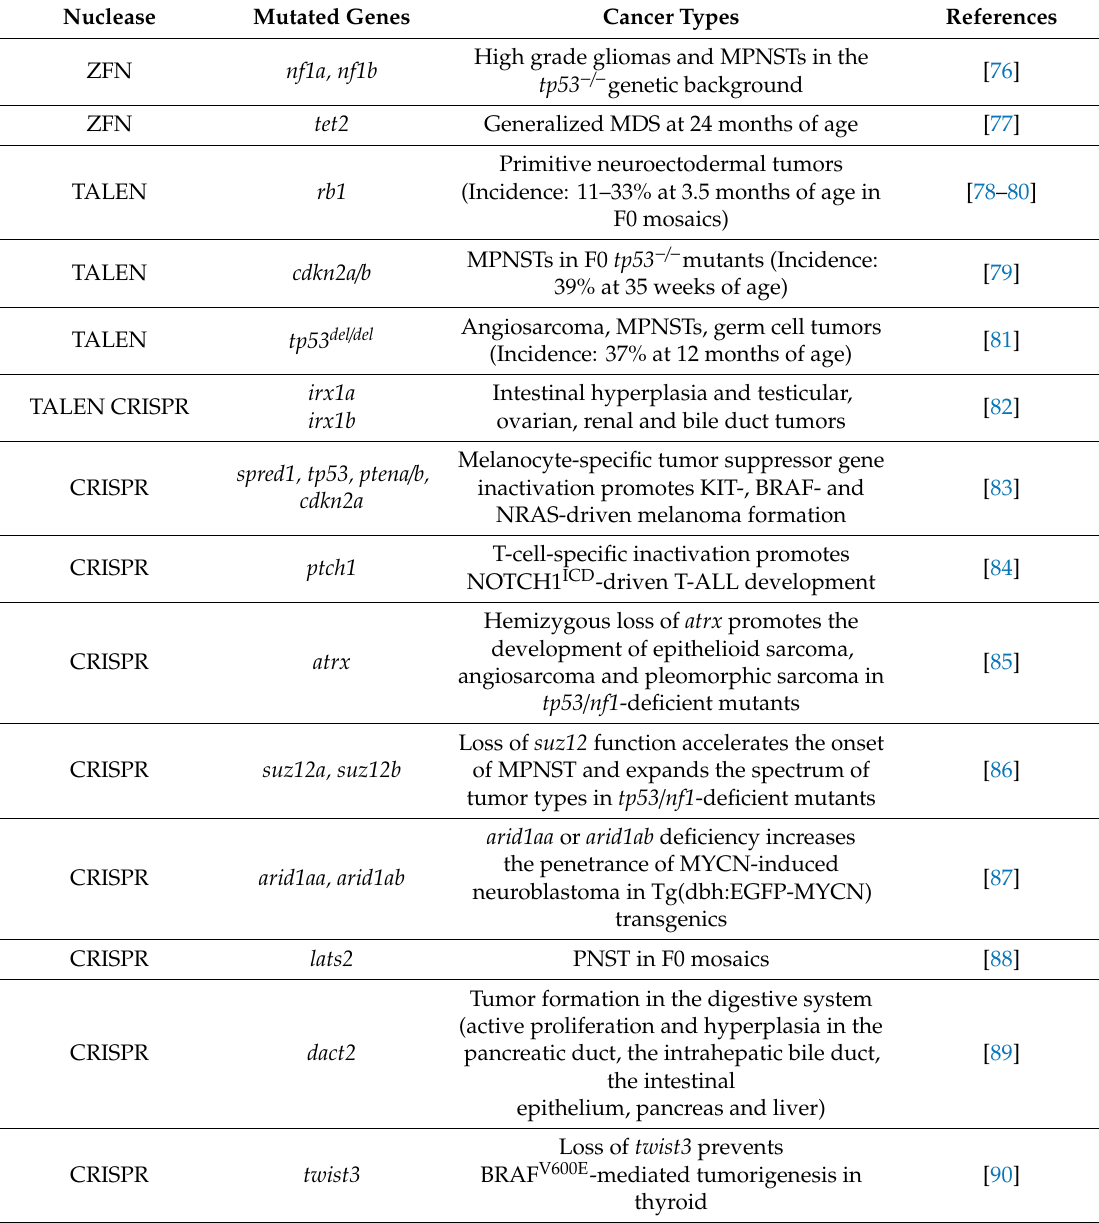
Table 4. Cancer genes targeted by programmable site-specific endonucleases in